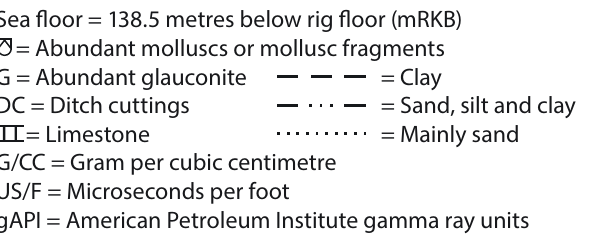
Figure 39. Well summary figure including resistivity log, density log, sonic log, gamma-ray log, lithology, lithostratigraphic units, series/sub-series, stage, paleobathymetry and analysed samples for the lower part of the investigated sequence in well 24/12–1 (upper Oligocene to lower Miocene) including the well type section for the Skade Formation (modified after Eidvin & Rundberg, 2007; Eidvin et al.,